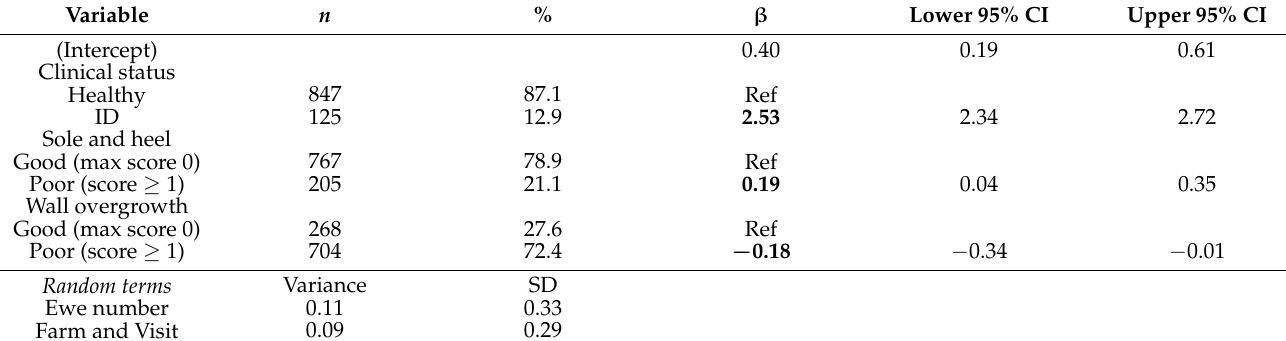
Table 10. Linear mixed effects model of load of Dichelobacter nodosus on all feet from 972 foot-level observations.